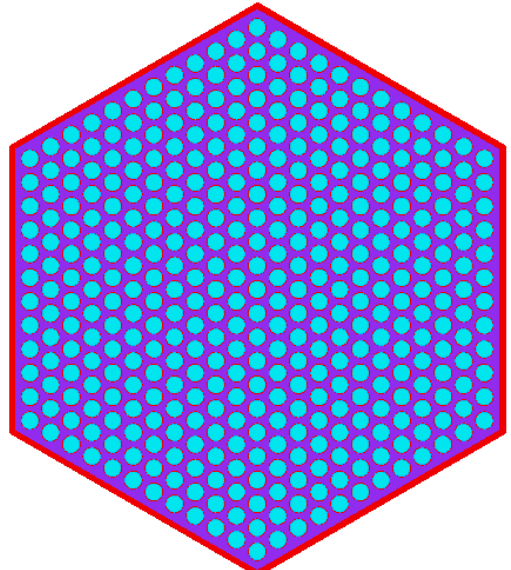
Figure 13. SCALE 6.2 model of radial RBWR-analogue assembly.